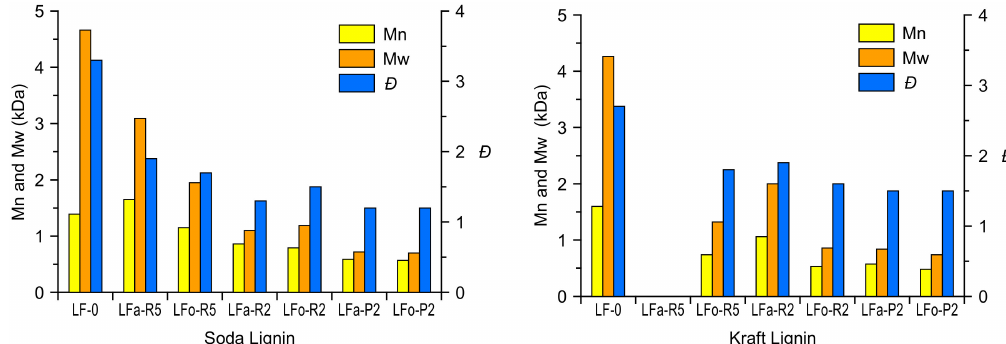
Figure 4. Comparison of the results of the aqueous and organic processes for S-LF-0 and K-LF-0 fractionation as Mn, Mw, and Ð by GPC analysis of resulting delivered